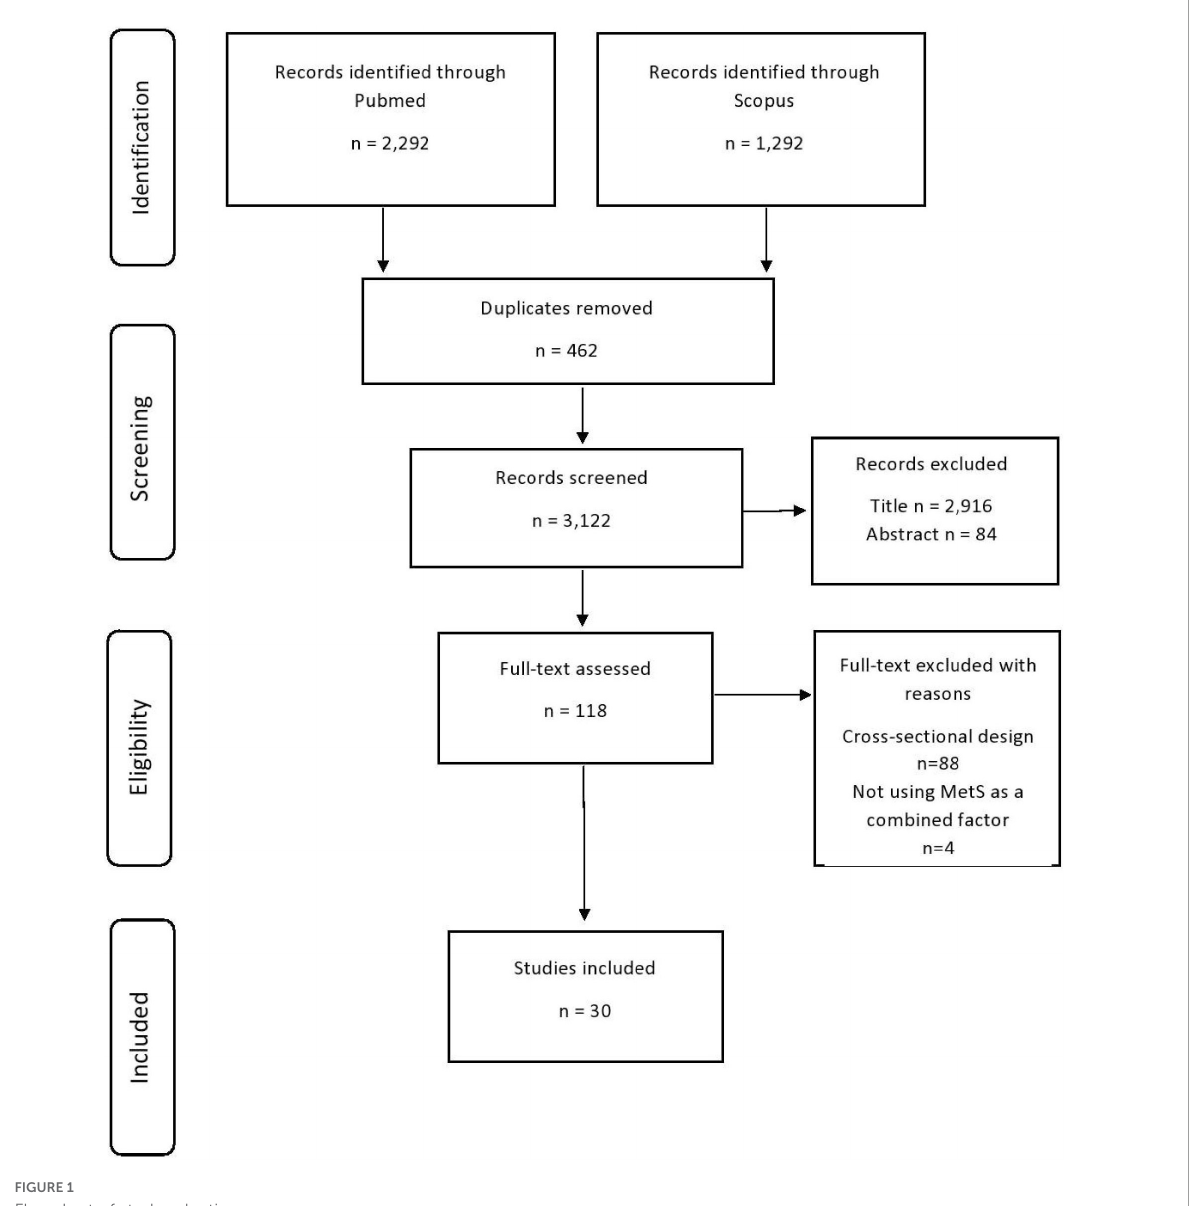
FIGURE1 Flowchart of study